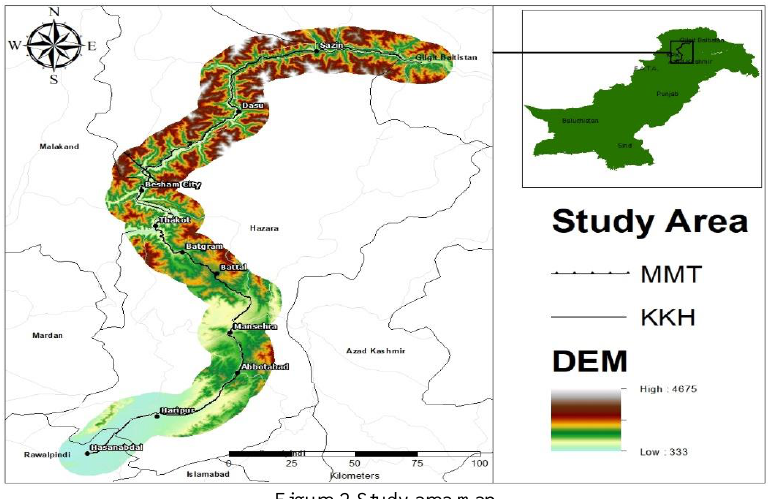
Figure 2 Study area